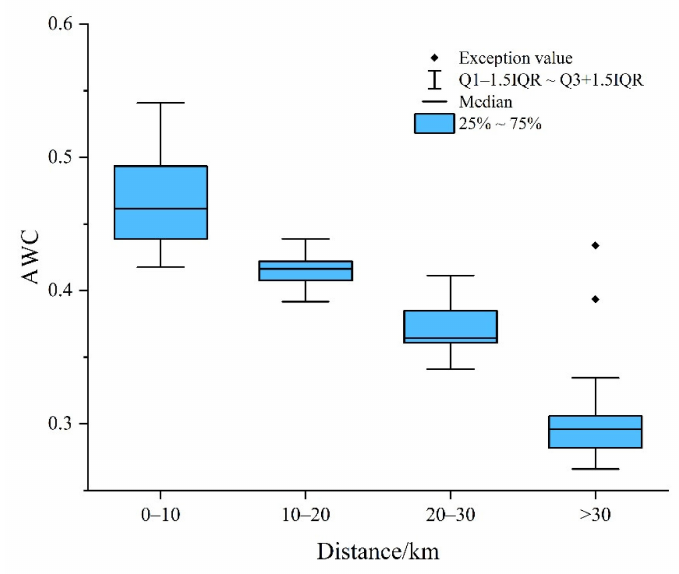
Figure 8. Box plots of the AWC between groundwater level and water stage of the Yellow River in Puyang under different distances away from the Yellow